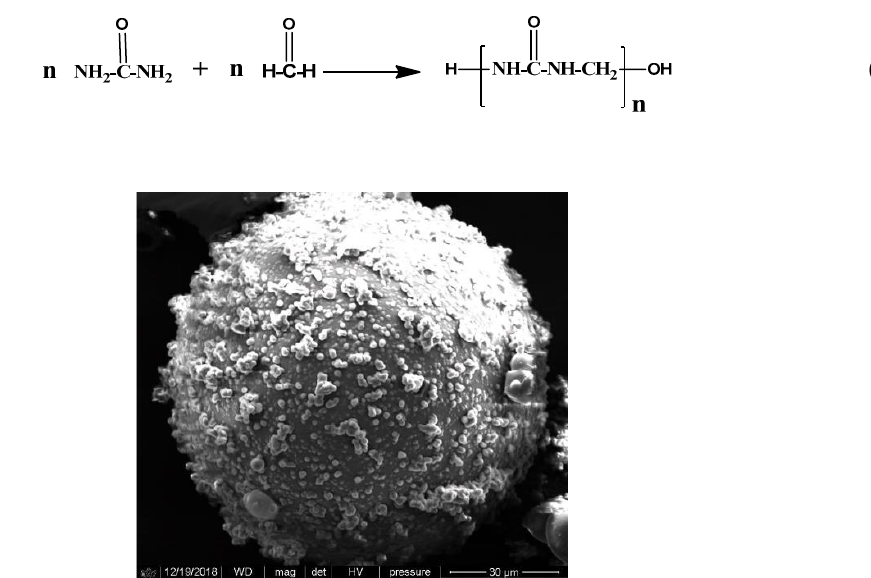
Figure 6. Scanning electron micrograph of dicyclopentadiene (DCPD)/PUF microcapsule.